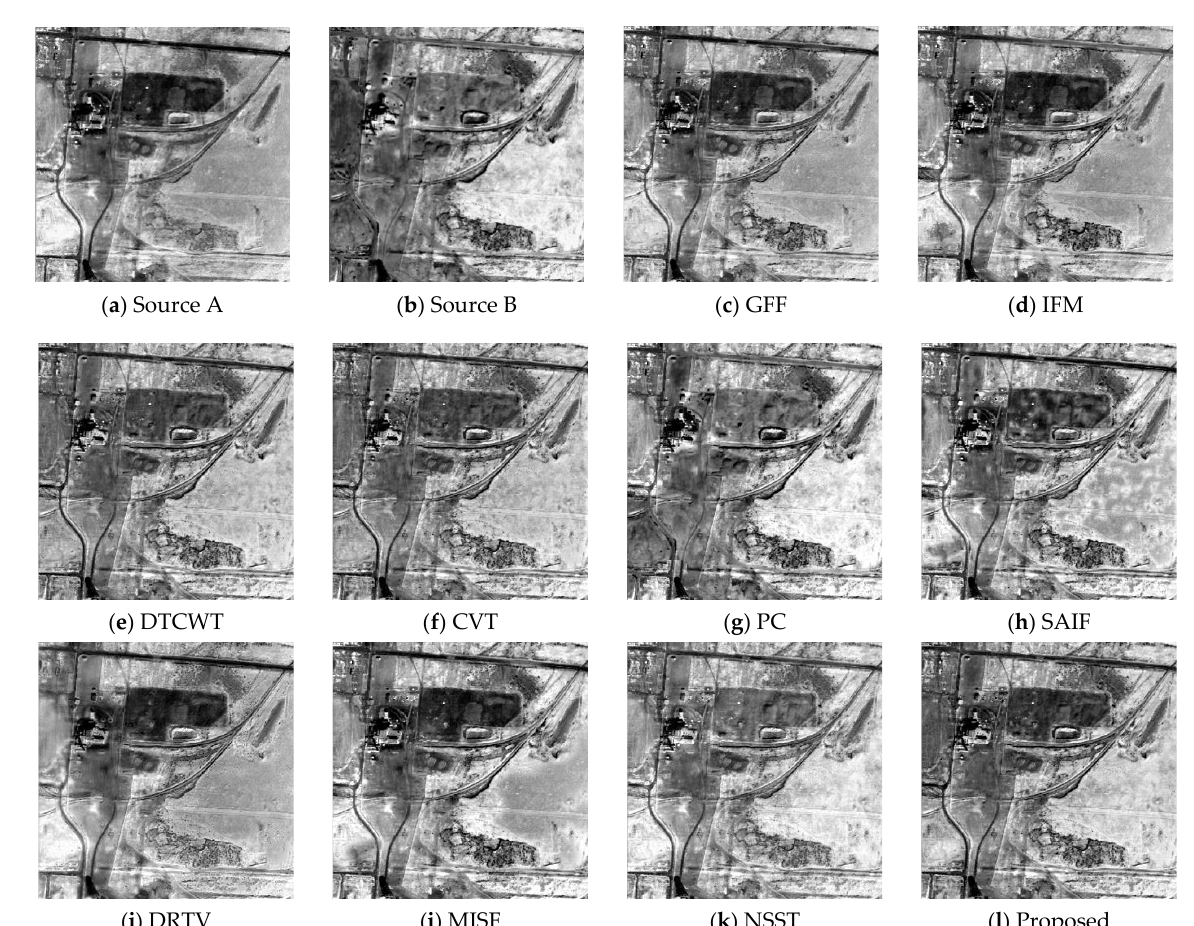
Figure 5. Fusion results of the second group of images. ( a ) Source A, ( b ) Source B, ( c ) GFF, ( d ) IFM, ( e ) DTCWT, ( f ) CVT, ( g ) PC, ( h ) SAIF, ( i ) DRTV, ( j ) MISF, ( k ) NSST, ( l ) proposed method.